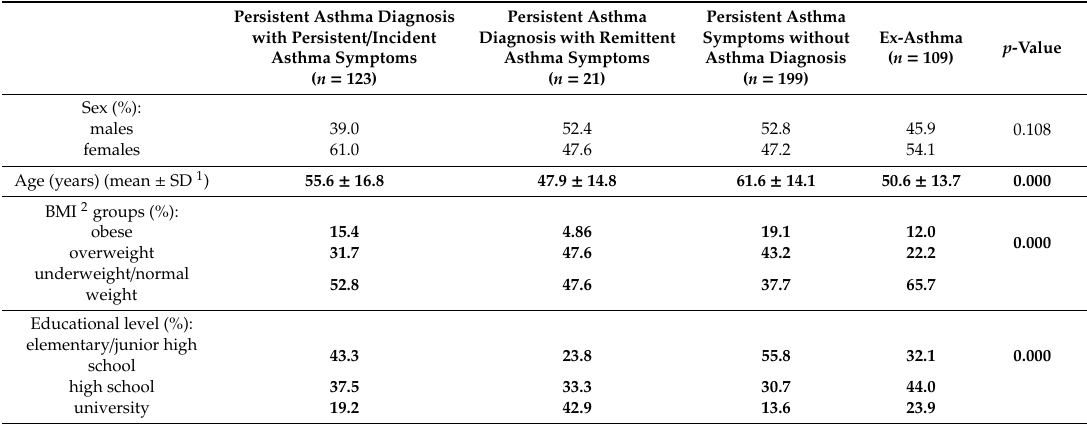
Table 4. Baseline descriptive characteristics by longitudinal asthma patterns.